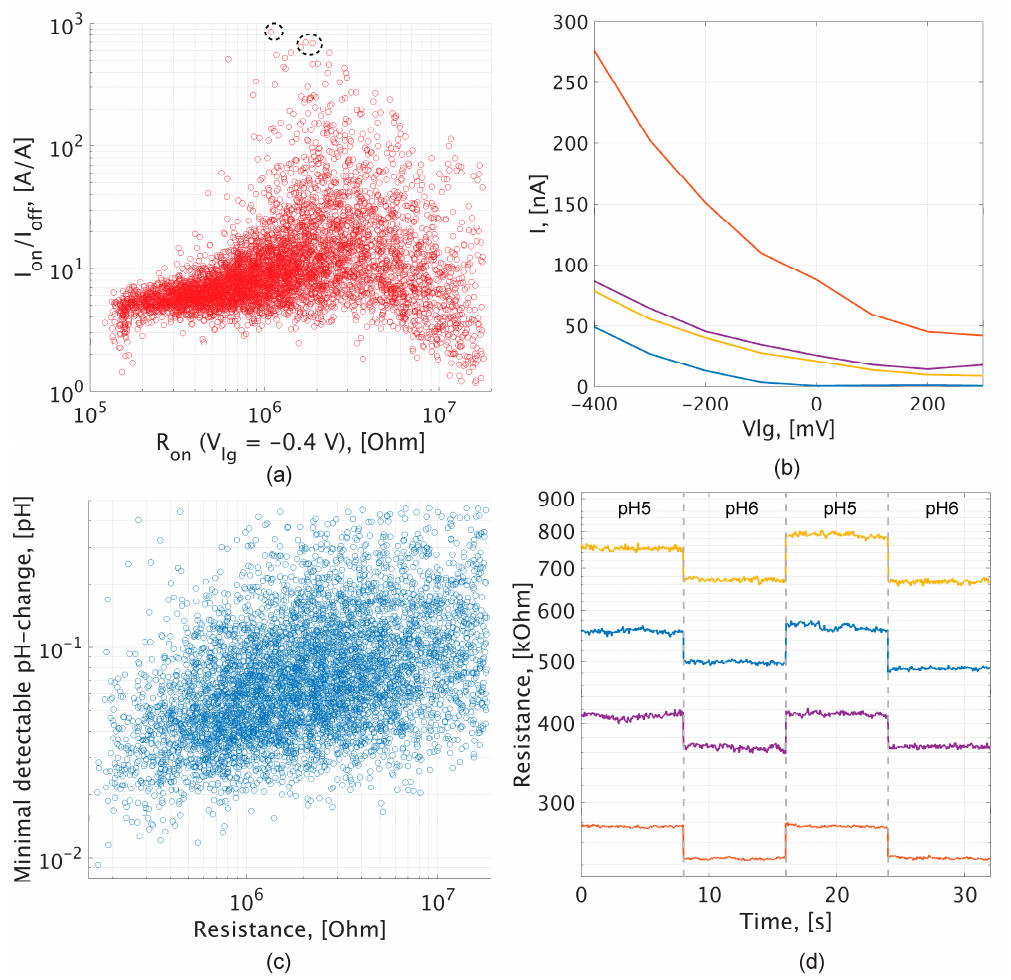
Figure 5. ( a ) Scatter plot of the I ON /I OFF ratio versus the R ON of all carbon nanotube field-effect transistors (CNTFET) devices of an array. ( b ) Current − voltage characterization (I-V curves) of CNTFETs with the largest I ON /I OFF . ( c ) Scatter plot of minimal detectable pH-changes versus R PH5 ; ( d ) Resistance changes versus time of 4 different CNTFET devices upon sweeping the pH values from 5 to 6 two times.